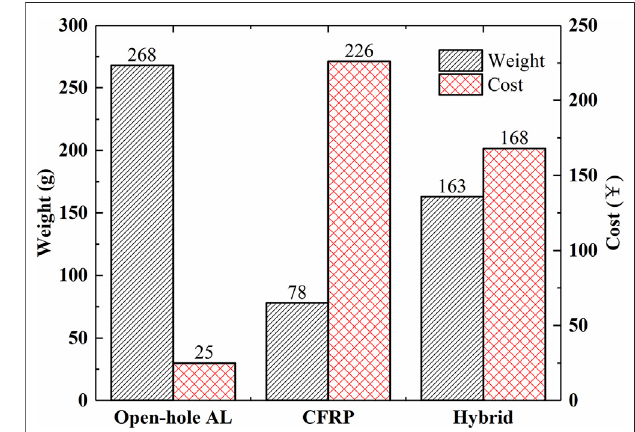
FIGURE 13 | Comparison of open-hole, CFRP, and hybrid tubes in weight and cost.